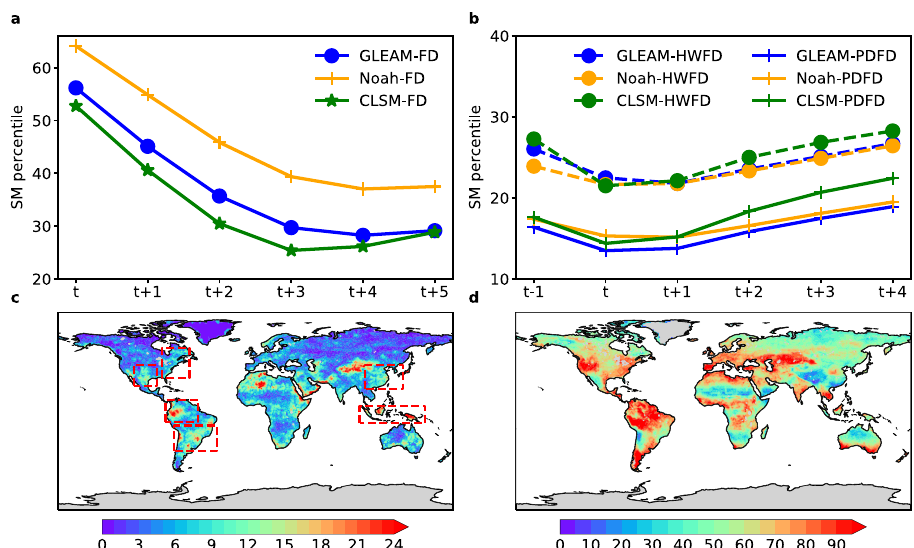
Fig. 1 Comparison of variations in SM percentiles and mean frequencies of fl ash droughts according to different de fi nitions from the perspective of intensi fi cation rate and duration. a , b Temporal variations in SM percentiles for fl ash drought events of all grid points based on two de fi nitions. Please note that the SM percentile represents the magnitude of the decline in SM, as shown in a , which was calculated for the whole time series. c , d Frequencies of occurrence of fl ash droughts based on two de fi nitions. Intensi fi cation rate-based de fi nition: SM decreases from above the 40th percentile to below the 20th percentile with an average decline rate of no less than the 5th percentile for each pentad, and the SM below the 20th percentile should last for no <3 pentads. If the declining SM rises up to the 20th percentile, fl ash droughts will terminate. Duration-based de fi nition: The pentad-mean surface T anomaly> one standard deviation, ET anomaly > 0, P anomaly< 0, and SM percentile < 40% for HWFD events. The pentad-mean surface T anomaly> one standard deviation, ET anomaly< 0, SM percentile < 40%, and P percentile< 40% for PDFD events. d Total numbers of HWFD and